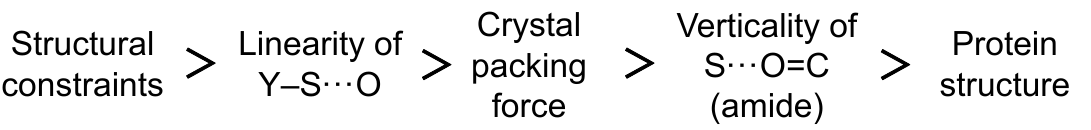
Figure 7. The factors that control molecular structure of organic molecules and proteins in the solid